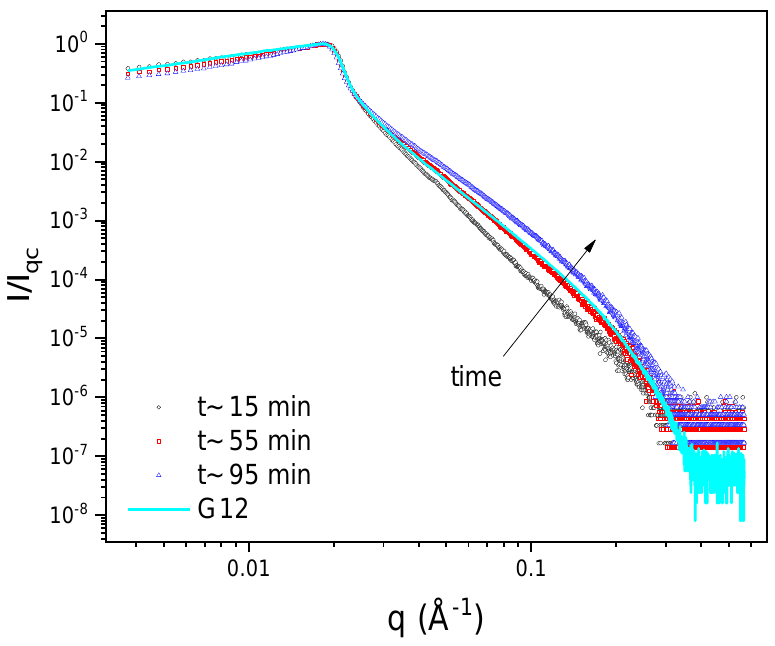
Figure 10. XRR curves as a function of time for 1 mg mL −1 PAA + 0.1 mM G12 at pH 11. The first curve ( black circles ) was obtained after an adsorption time of about 15 min (the time needed to prepare the experiments). The second ( red squares ) and third ( blue tringles ) measurements were performed after 55 and 95 min, respectively. We included for comparison the curve corresponding to PAA-free Gemini monolayer (the same as in Figure 8a; cyan line ). The plot is in log-log scale. Error bars were removed for ease of visualization.